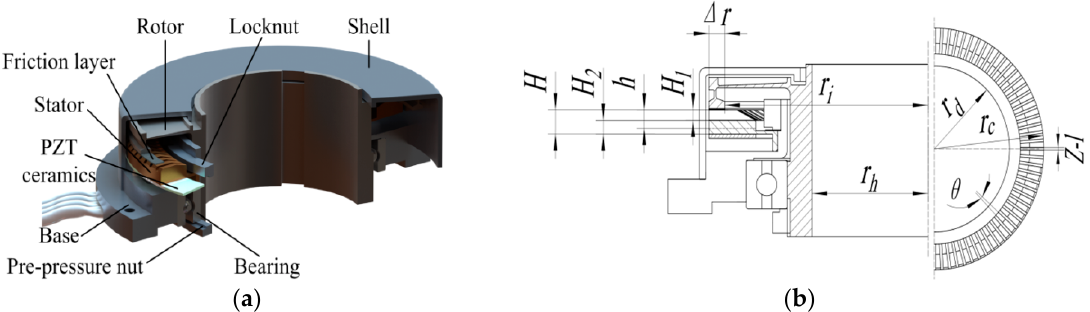
Figure 1. Hollow ultrasonic motor, ∅ 70 mm: ( a ) 3D structure of 70H; ( b ) some essential size parameters of 70H.